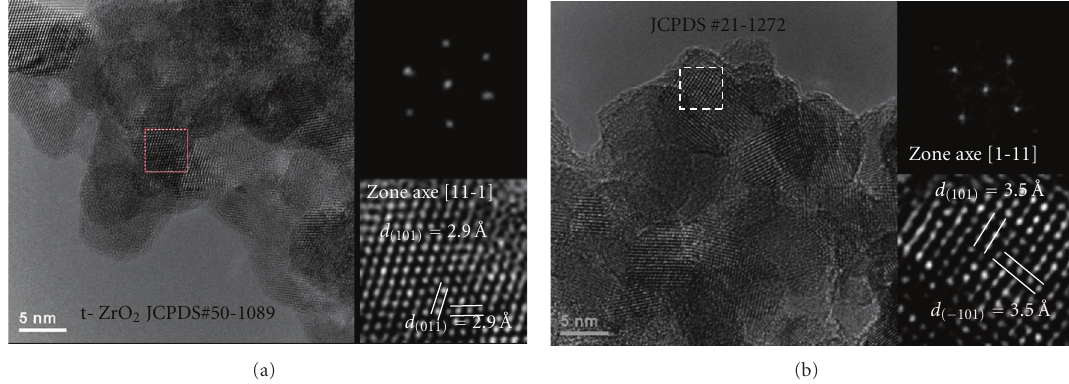
Figure 4: HRTEM images of T20Z-400 sample showing the nanoparticles forming the nanoconjugates, inserts present the FFT and the high-resolution indexed zone. (a) Zirconia nanocrystal indexed as tetragonal phase, (b) titania nanocrystal indexed as anatase